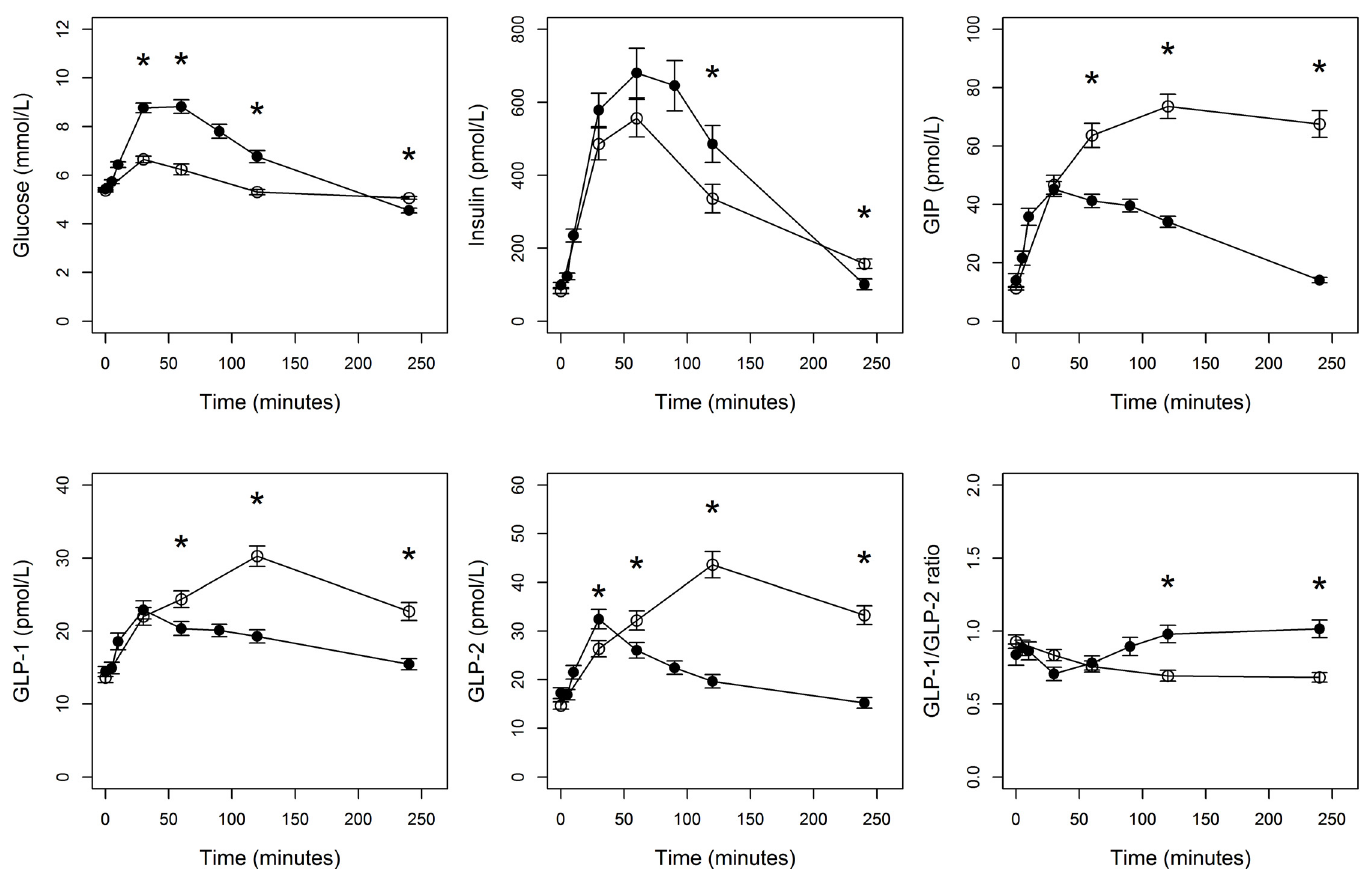
Fig 1. Responses of glucose, insulin, GLP-1, GLP-2 and GIP after fat-rich meal (open circles) and OGTT (black circles). Data show mean ± SEM. Stars indicate significant (p-value < 0.05) difference between fat-rich meal and OGTT for a given time